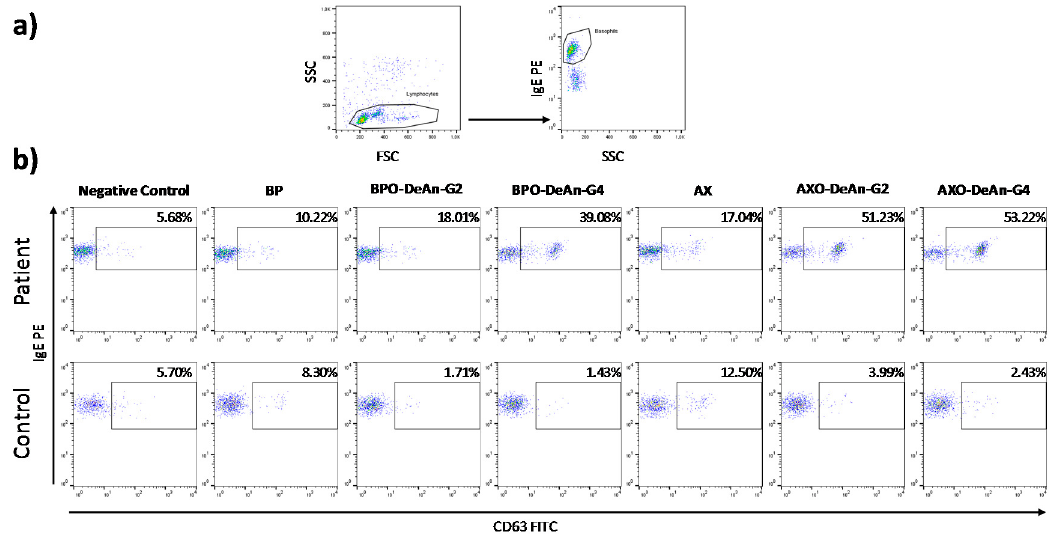
Figure 2. Cytometry dot plots showing: ( a ) basophils selection strategy; ( b ) a representative example (patient 3 and control 2) of results for all the immunogens tested, including native drug and DeAns.